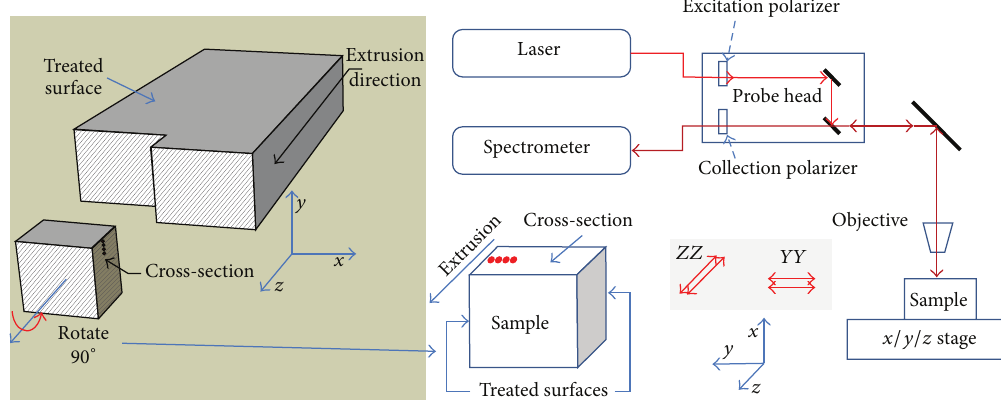
Figure 1: Schematic illustration of how a board was cut and analyzed by micro-Raman